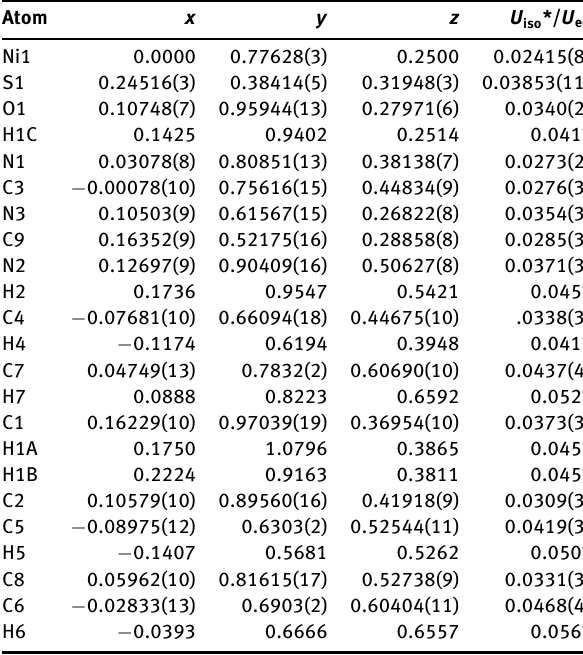
Table 2: Fractional atomic coordinates and isotropic or equivalent isotropic displacement parameters (Å 2